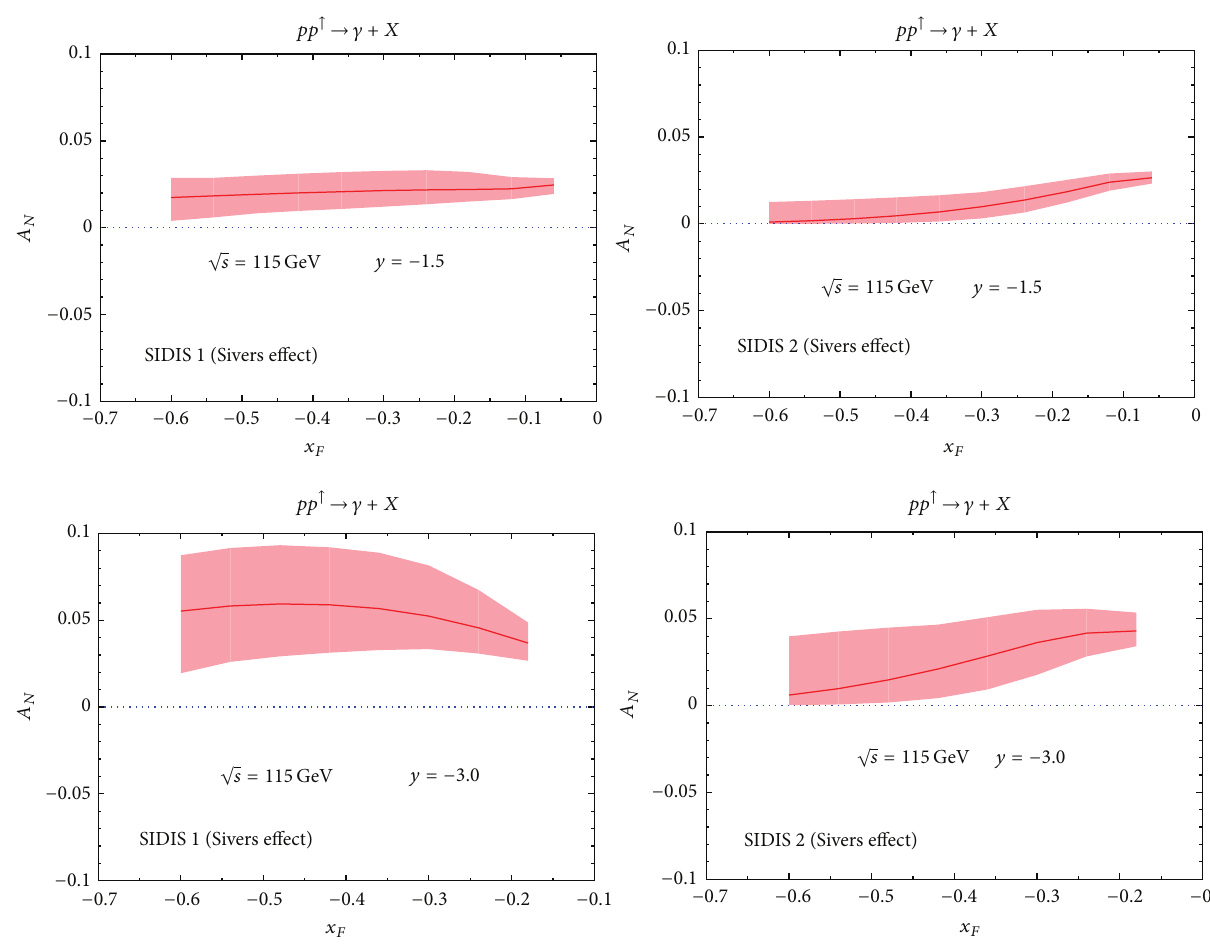
Figure 5: Our theoretical estimates for 𝐴 𝑁 versus 𝑥 𝐹 at √𝑠 = 115 GeV, 𝑦 = − 1 . 5 (upper plots), and 𝑦 = − 3 . 0 (lower plots) for inclusive photon production in 𝑝𝑝 ↑ → 𝛾𝑋 processes, computed according to (6) and (7) of the text. Only the Sivers effect contributes. The computation is performed adopting the Sivers functions of [20] (SIDIS 1, left panels) and of [21] (SIDIS 2, right panels). The overall statistical uncertainty band, also shown, is obtained following the procedure described in Appendix A of [21].